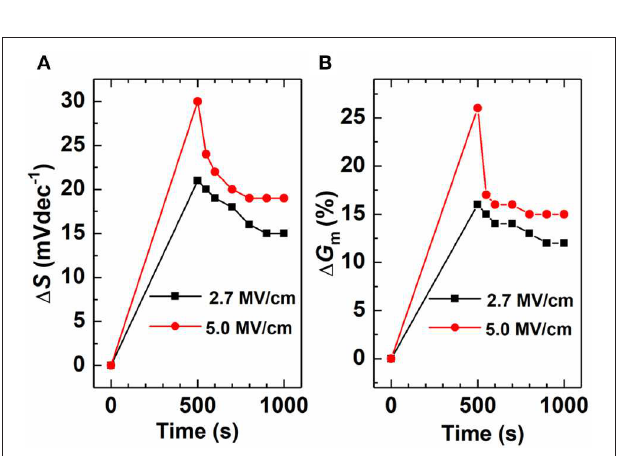
FIGURE 7 | Time-dependence of (A) 1 S and (B) 1 G m in stress (0 and 500s) and recovery (500–1,000s) phases.